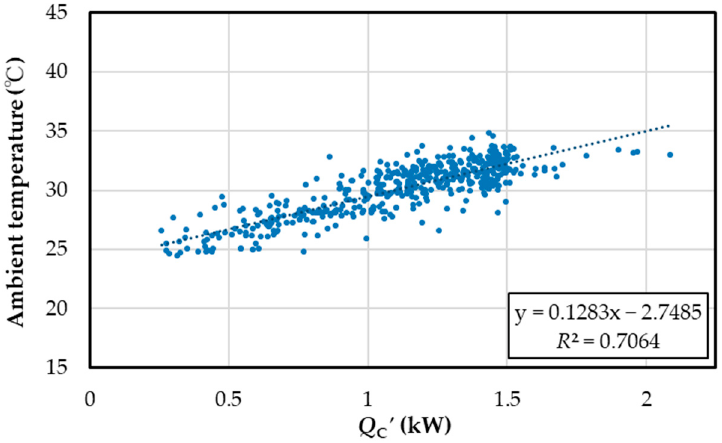
Figure 4. The relationship between Q c (cid:48) and the hourly average outdoor